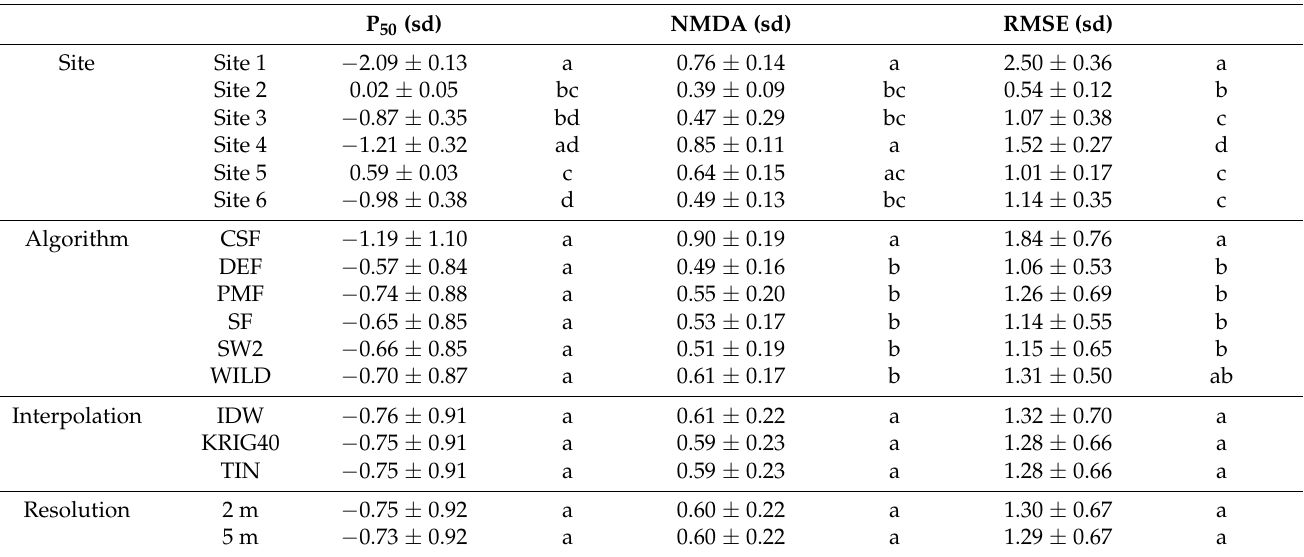
Table 5. Mean and standard deviation of the uncorrected elevation differences between low- and high-density LiDAR datasets (i.e., DEMs of difference) measured by the 50th percentile (P 50 ), the normalized median absolute deviation (NMAD) and the root mean square error (RMSE) grouping by sites (sites), classification filters, interpolation methods and spatial resolutions. Letters indicate significant differences within groups according to the post-hoc Dunn ´ s non-parametric test for Kruskal-type ranked data with a significance level of p <